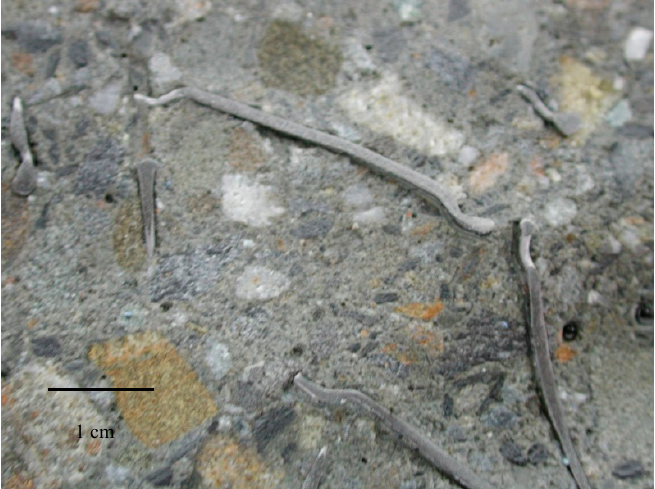
Figure 3. Concrete surface at the end of 72 h of testing (w/cm = 0.50, ASTM C1138).